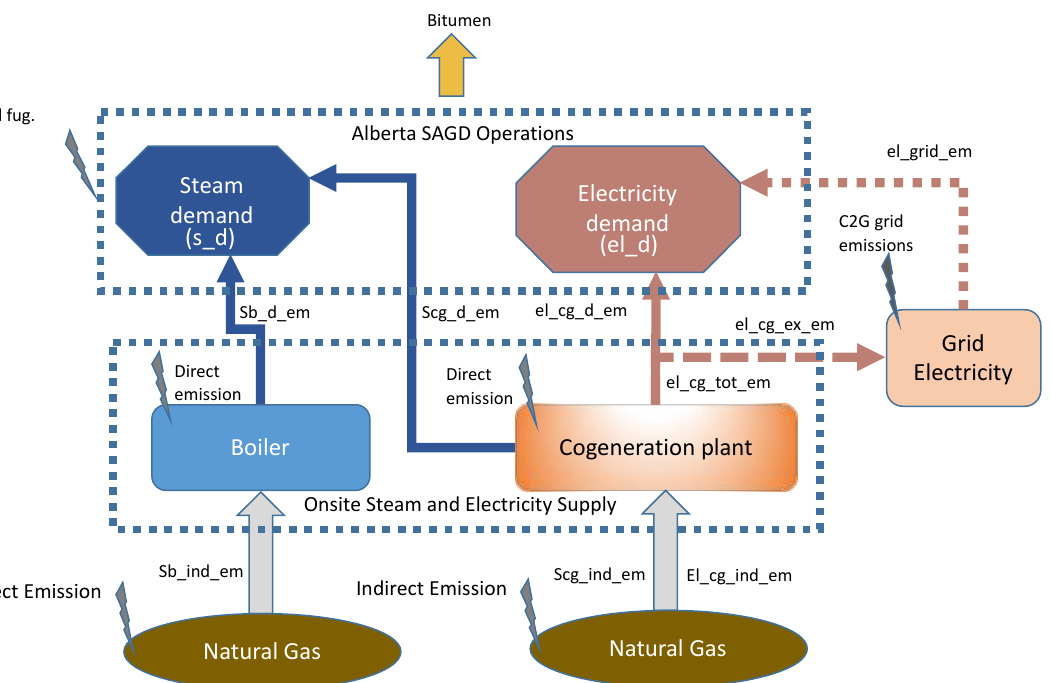
Figure 1. Schematic flow diagram presenting the research methodology followed in the study with GHG emissions categories. (Abbreviations: Sb_ind_em: steam boiler indirect emissions; Sb_d_em: Steam boiler direct emissions; Scg_d_em: steam cogeneration direct emissions; Scg_ind_em: steam cogeneration indirect emissions; El_cg_ind_em: electricity cogeneration indirect emissions; el_cg_tot_em: electricity cogeneration total emissions; el_cg_d_em: electricity cogeneration direct emissions; el_cg_ex_em: electricity cogeneration exported emissions; el_grid_em: electricity from